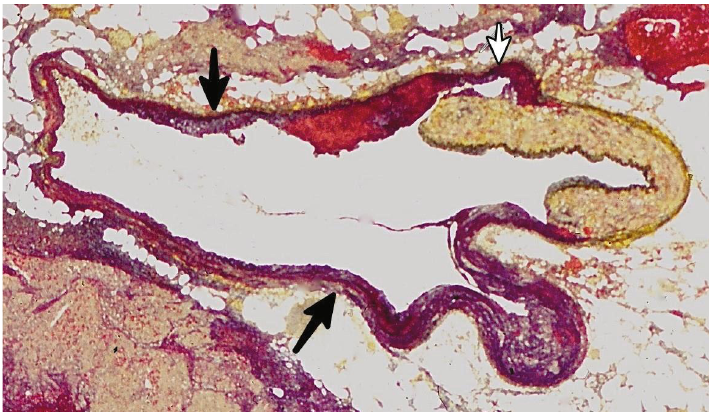
Figure 10: Segmental arterial mediolysis injurious phase. The black arrows point to a large fi brin outlined gap aneurysm. The white arrow shows the site of an early dissection. Movat stain × 25 (adapted with permission from Cardiovascular Pathology 18(6) copyright 2009, Elsevier Inc.).